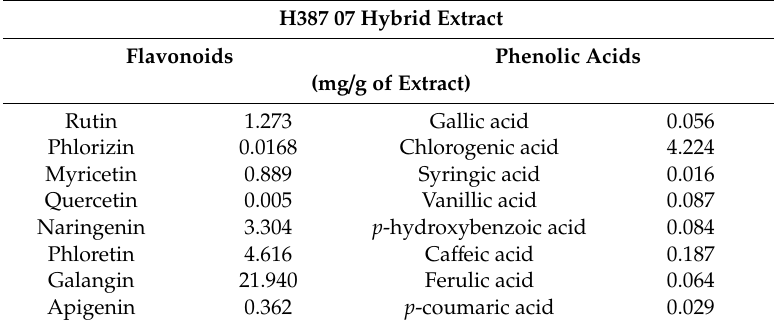
Table 1. Concentration of flavonoids and phenolic acids in the extract of fruits of hybrid H387 07 obtained from HPLC.